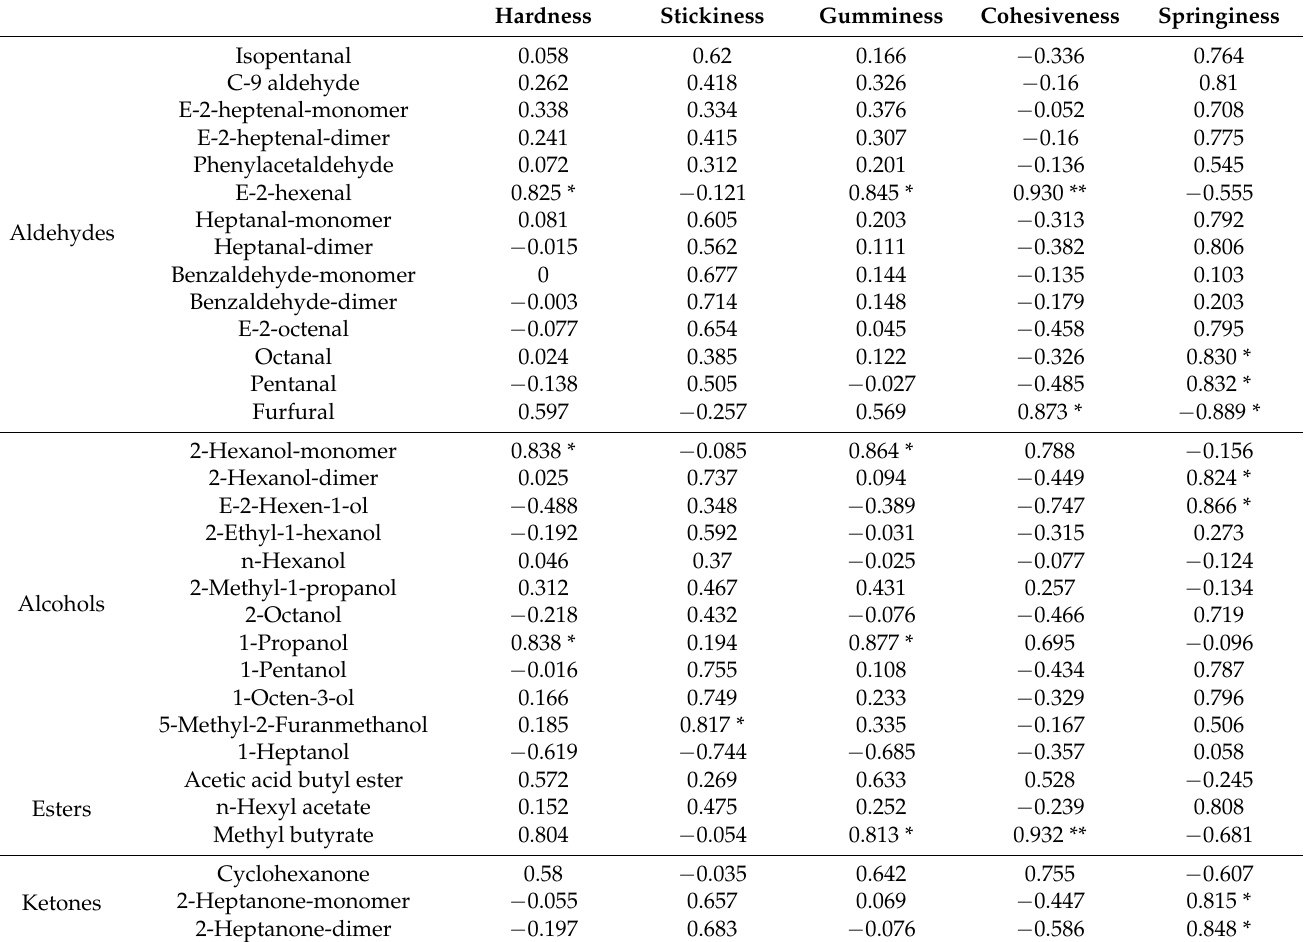
Table 5. Pearson correlation analysis between textural parameters and aromas for cooked rice